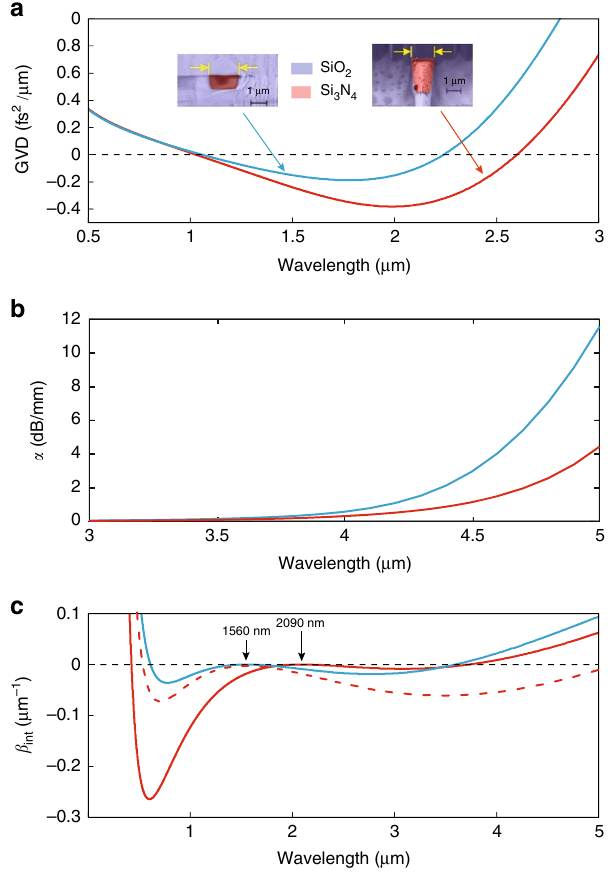
Fig. 1 Comparison between standard and large cross-section silicon nitride (Si 3 N 4 ) waveguides. a Group velocity dispersion (GVD) for the TE fundamental mode of a standard waveguide with cross-section 870 × 1700 nm 2 (blue) and the TM fundamental mode of a large cross-section waveguide with dimension 2177 × 1150 nm 2 (red). The insets show scanning electron microscope (SEM) images of the waveguide cross- section. b Attenuation coef fi cient α as a function of wavelength for (blue) standard and (red) large cross-section waveguides. c Solid lines: integrated dispersion as a function of the wavelength for the standard waveguide pumped at 1560nm (blue) and the large cross-section one pumped at 2090 nm (red). The dispersive wave (DW) phase matching points lie in the same region for both con fi gurations. Dashed red line: integrated dispersion as a function of the wavelength for the large cross-section waveguide pumped at 1560nm. Pump positions are indicated by the